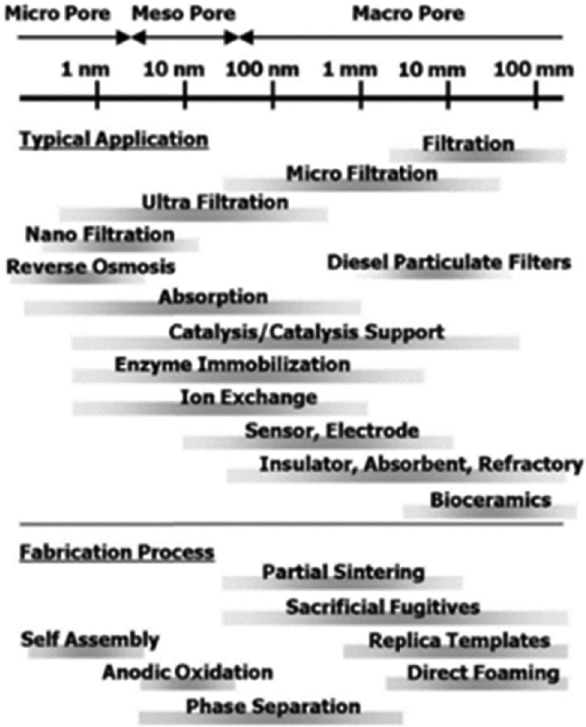
Figure 10: Categorization of di ff erent pores with relative manufac - turing techniques [ 46 ] .